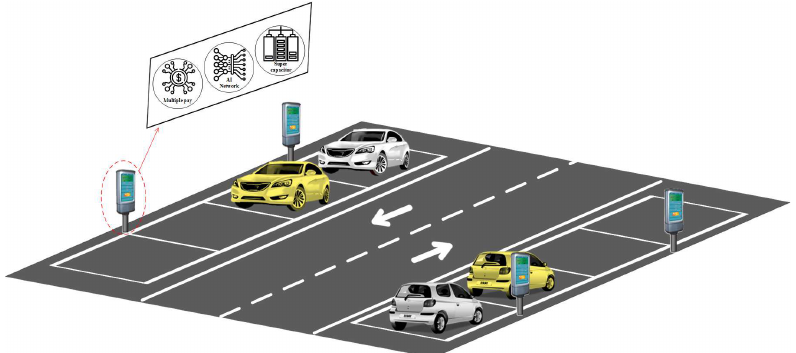
Figure 1. The overall concept of artificial intelligence unmanned parking meter